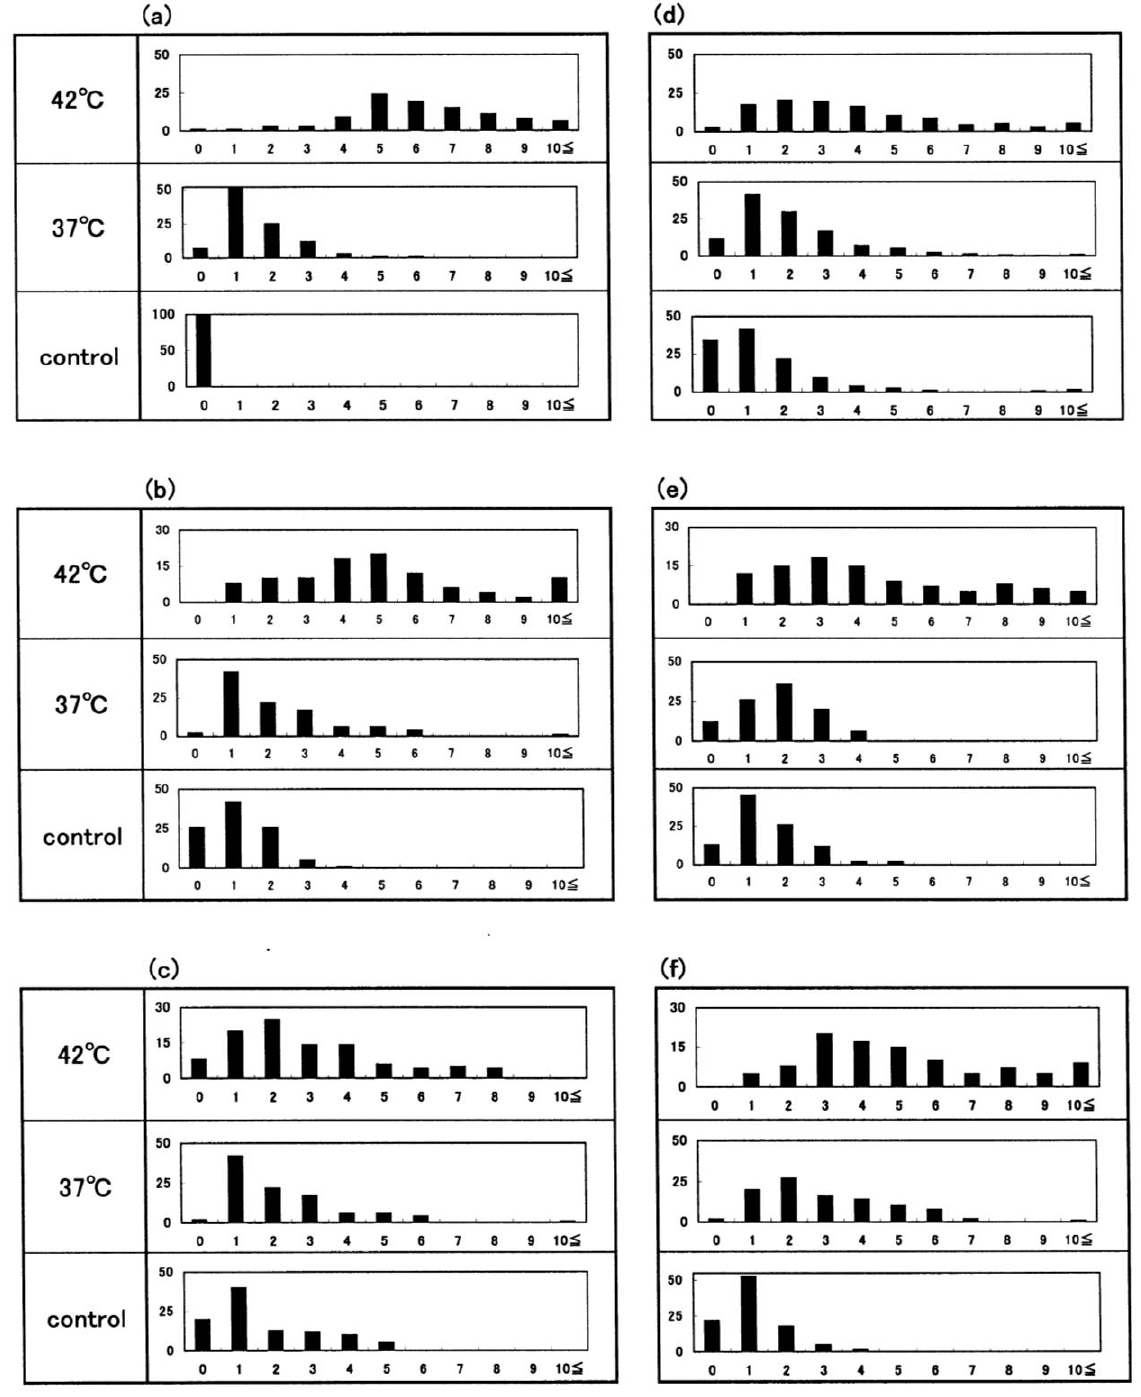
Figure 4. Histograms represent Heinz bodies detected in blood samples after mild heating above 37 °C, redrawn from Sugawara et al. [14]. The histograms for 37 °C and 42 °C are displayed using a temperature-untreated sample as a reference. One hundred red cells were chosen and the number of Heinz bodies contained in each red cell was counted. Figure 4a was constructed from the microscopic views shown in Figure